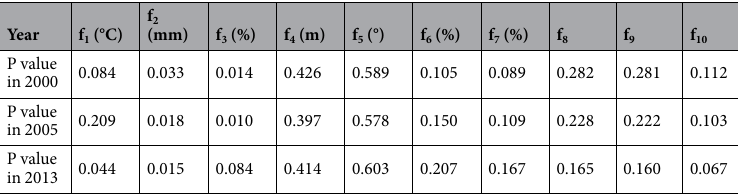
Table 2. Geographically determined weightings of factors affecting carbon sinks.